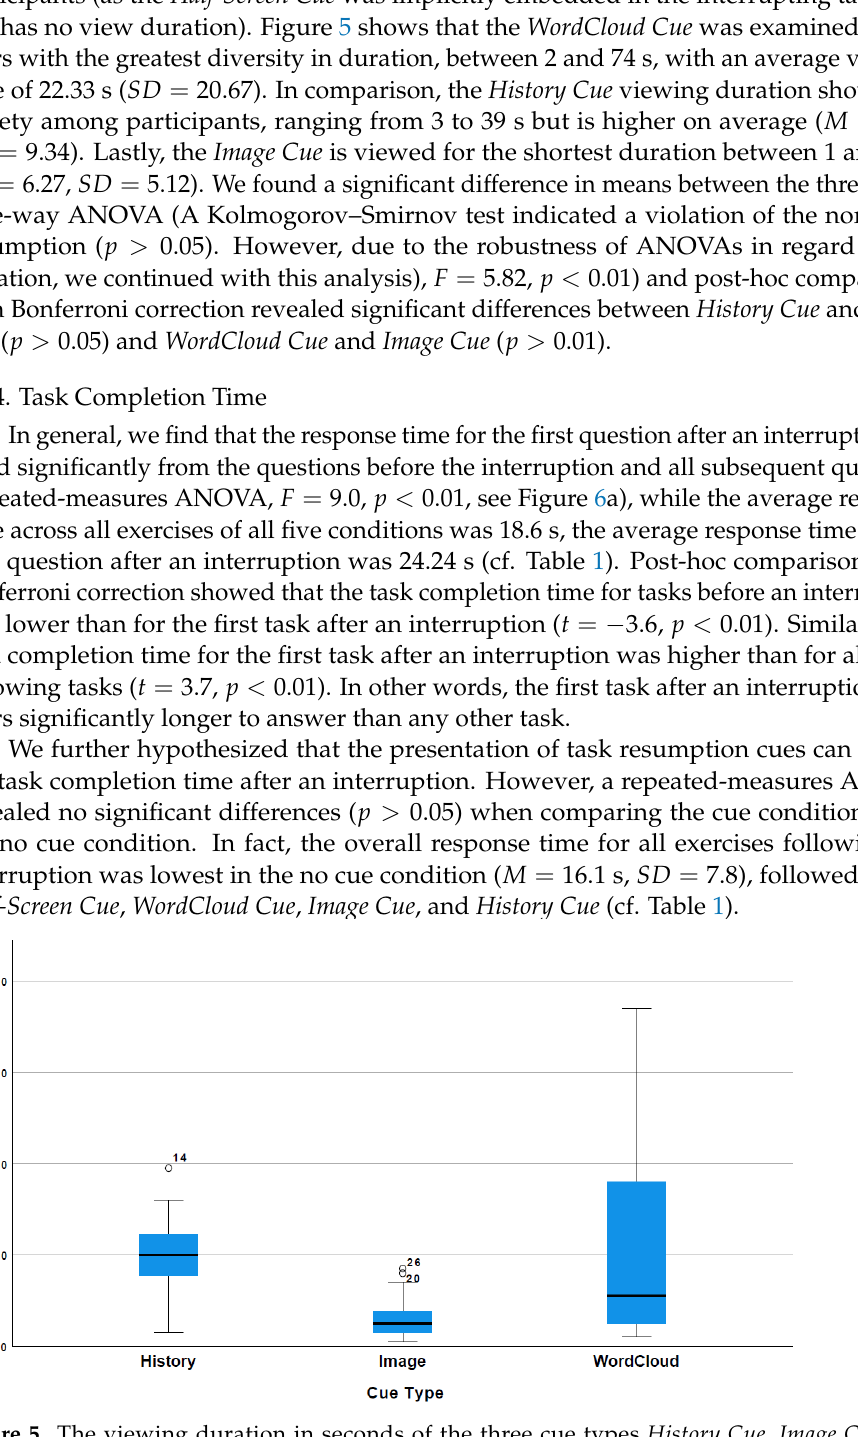
Figure 5. The viewing duration in seconds of the three cue types History Cue , Image Cue , and WordCloud Cue